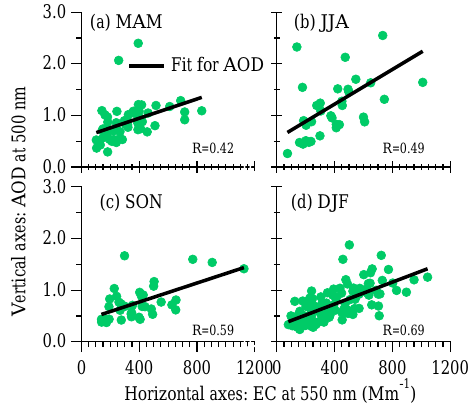
Figure 12. Relationships between surface EC at 550nm and col- umn AOD at 500nm in spring (a) , summer (b) , autumn (c) and winter (d)